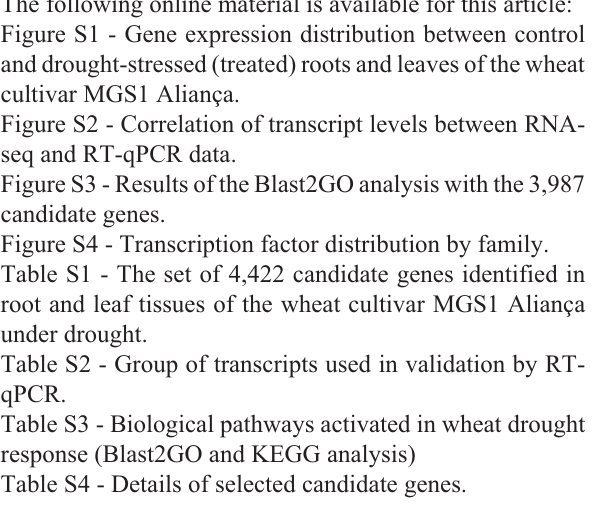
Figure S1 - Gene expression distribution between control and drought-stressed (treated) roots and leaves of the wheat cultivar MGS1 Aliança. Figure S2 - Correlation of transcript levels between RNA- seq and RT-qPCR data. Figure S3 - Results of the Blast2GO analysis with the 3,987 candidate genes. Figure S4 - Transcription factor distribution by family. Table S1 - The set of 4,422 candidate genes identified in root and leaf tissues of the wheat cultivar MGS1 Aliança under drought. Table S2 - Group of transcripts used in validation by RT- qPCR. Table S3 - Biological pathways activated in wheat drought response (Blast2GO and KEGG analysis) Table S4 - Details of selected candidate